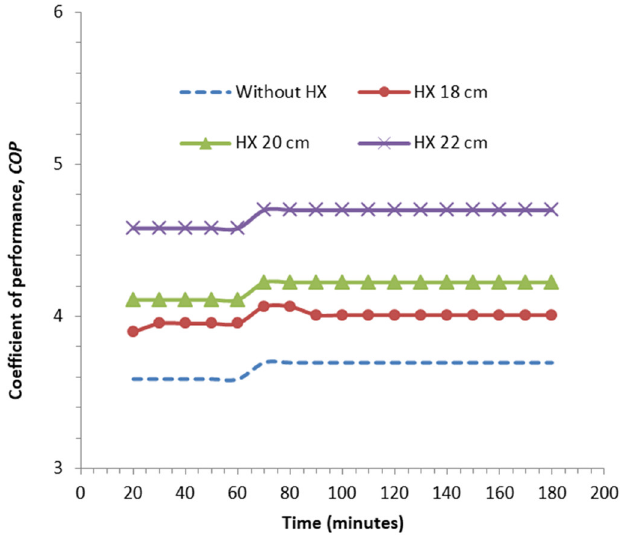
Figure 12. Coefficient of performance of the air conditioner using subcooler for three different lengths of heat exchanger.